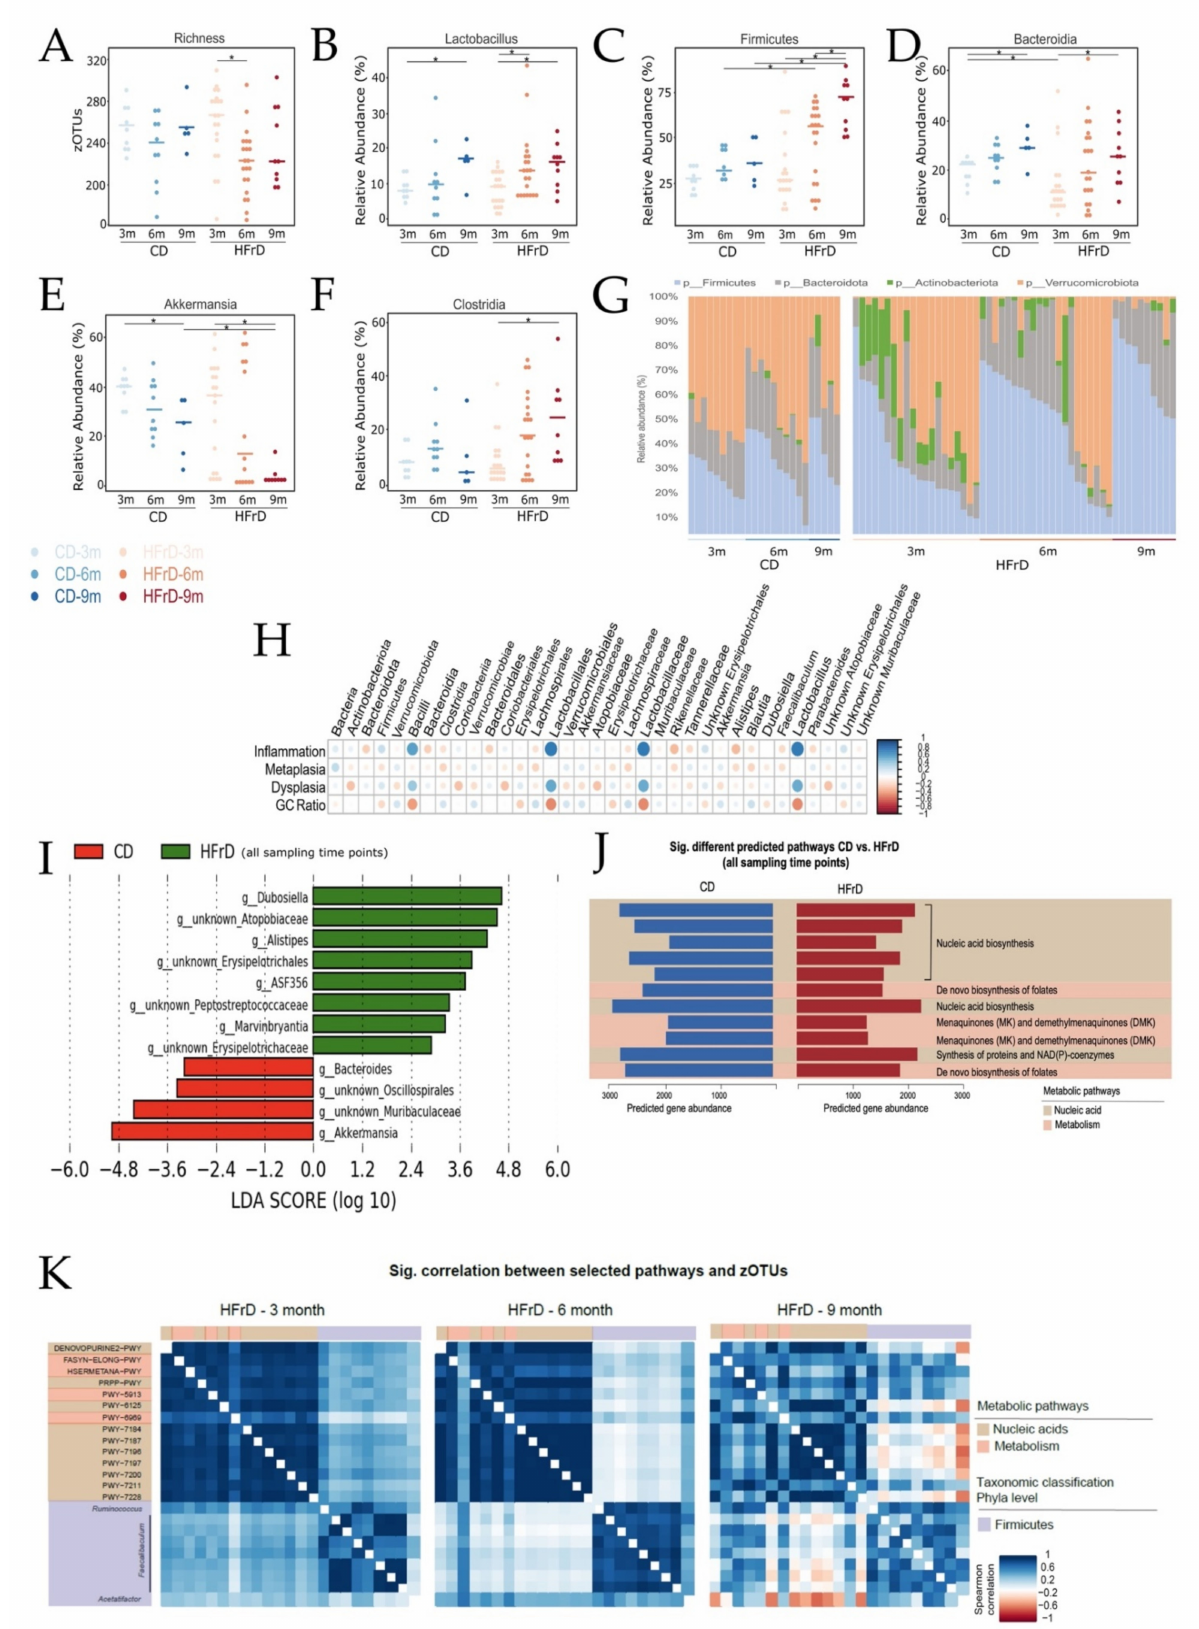
Figure 2. Graphical representation of richness and abundance of Lactobacillus, Firmicutes, Bacteroidia, Akkermansia, and Clostridia in gut microbiome. ( A ) Richness. HFrD-fed mice showed an age-dependent decrease in richness (pHFrD:3–6m =